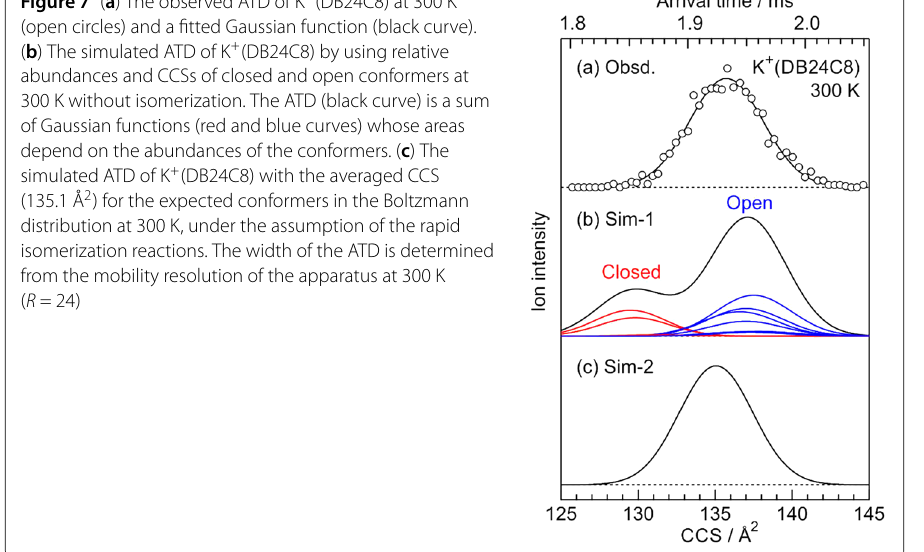
Figure 7 ( a ) The observed ATD of K + (DB24C8) at 300 K (open circles) and a fitted Gaussian function (black curve). ( b ) The simulated ATD of K + (DB24C8) by using relative abundances and CCSs of closed and open conformers at 300 K without isomerization. The ATD (black curve) is a sum of Gaussian functions (red and blue curves) whose areas depend on the abundances of the conformers. ( c ) The simulated ATD of K + (DB24C8) with the averaged CCS (135.1 Å 2 ) for the expected conformers in the Boltzmann distribution at 300 K, under the assumption of the rapid isomerization reactions. The width of the ATD is determined from the mobility resolution of the apparatus at 300 K ( R =